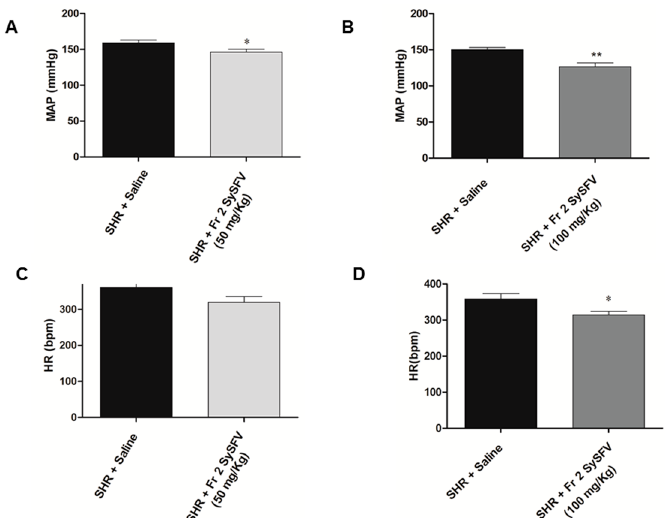
Figure 2. Representative tracings illustrating the changes in pulse arterial pressure (PAP, mmHg), mean arterial pressure (MAP, mmHg) and heart rate (HR, bpm) in spontaneously hypertensive rats (SHR) pretreated with Fr 2 SySFV at 50 mg/kg ( A ) and 100 mg/kg ( B ) p.o. and in saline-treated controls.